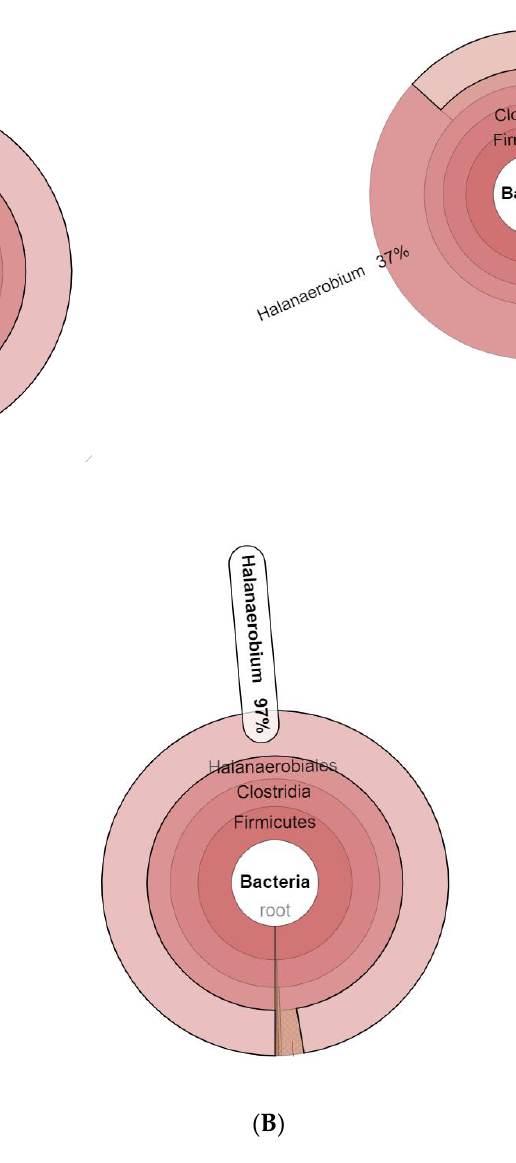
Figure 5. Krona analysis displaying the most abundant genera of the three extremely halophilic microbial samples. The names of the extremely halophilic microbial samples ( A1 , A2 and B ) are written below each Krona figure.